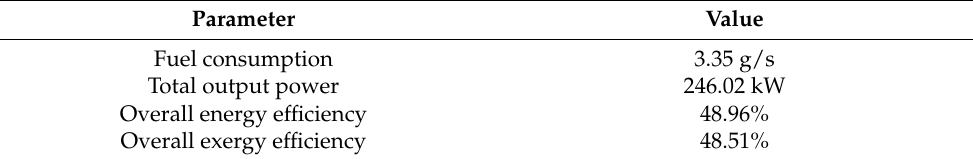
Table 5. The corresponding system performance results at the current density of 7.0 (A/cm 2